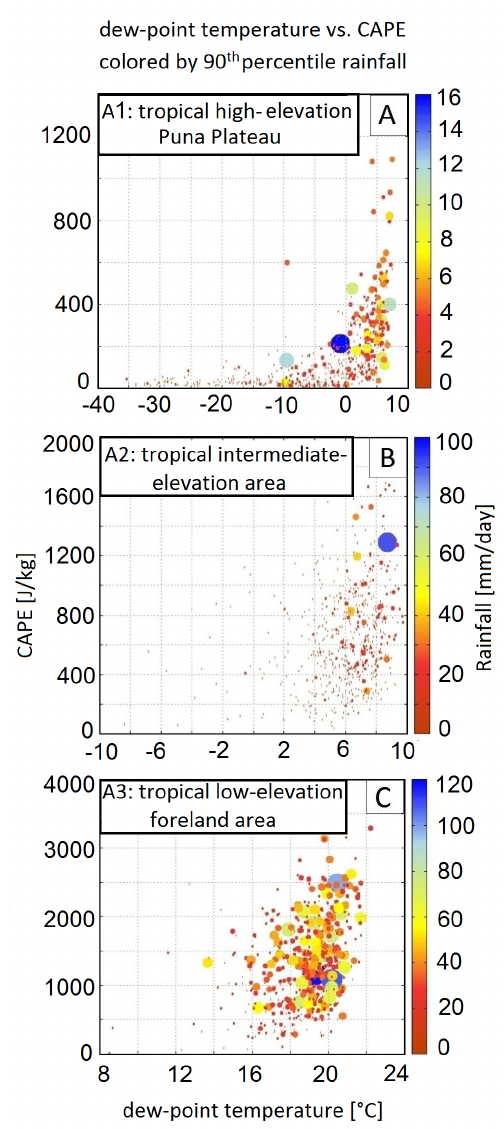
Figure 9. Scatterplot showing dew-point temperature vs. CAPE colored by the 90th percentile rainfall amounts for boxes A1 ( A ), A2 ( B ) and A3 ( C ). Point sizes are also scaled by rainfall amount. We have separately regressed the daily rainfall events that are above the 90th percentile onto daily values of dew-point temperature (Figure 10) and CAPE (Figure 11) to quantify conditions leading to extreme rainfall. We show the effect of temperature with respect to atmospheric humidity ( T d ) and also with respect to convection (CAPE) for deep-convective storms [20]. This is particularly pronounced in the eastern south–central Andes along the latitude 22–28 ◦ S with a high distribution of MCS during austral summer months [62]. The regression coefficient ( a ) for the dew-point temperature and the regression coefficient ( b ) for CAPE reveal values around the CC relation and parcel theory, respectively. The regression coefficient ( a ) for the dew-point temperature is higher in the tropical and the transition zone between the tropical and subtropical areas and over intermediate-elevation (Box A2) and low-elevation foreland (Box A3) regions as compared to high-elevation Puna Plateau and subtropical regions (Figure 10). The regression coefficient ( b ) for the CAPE is higher in the transition zone between the tropical and subtropical and over the intermediate-elevation area as compared to all others regions (Figure